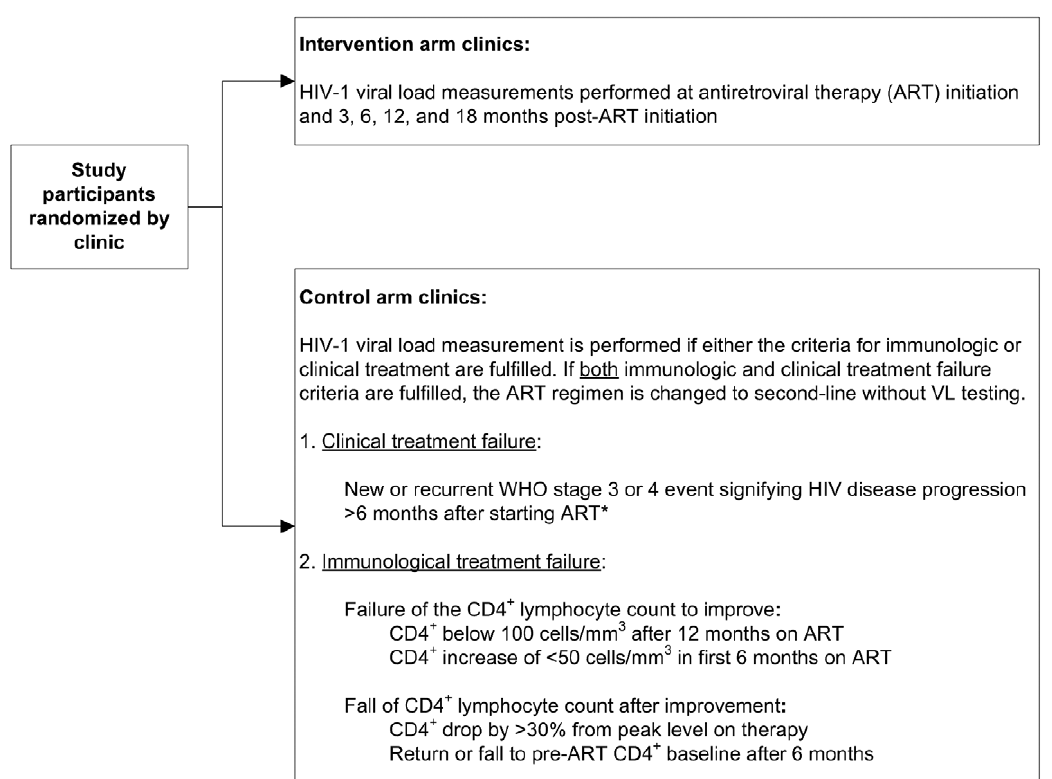
Figure 1. Design of the Viral Load Study. * Immune Reconstitution Syndrome (IRIS) is not considered evidence of clinical treatment failure. The assessment of whether a clinical event represents IRIS or a genuine incident opportunistic infection is determined locally by the clinician. Note: when clinical or immunologic criteria for therapeutic failure are met, a procedure for allocating ‘discretionary’ viral load testing is utilized. Any evident infections are investigated and treated. In cases of suspected immunologic treatment failure, the CD4 + lymphocyte count is repeated one month after treatment of infection and/or intensive adherence counseling. If the patient still meets criteria for therapeutic failure after adherence is judged to be excellent and (in cases of immunologic failure) after a repeat CD4 + lymphocyte count, HIV-1 viral load testing is performed for those patients meeting either clinical or immunologic criteria, but not both. Patients meeting both clinical and immunologic criteria for therapeutic failure are assumed to have virologic failure and the decision to change to ART regimen is made without viral load testing.